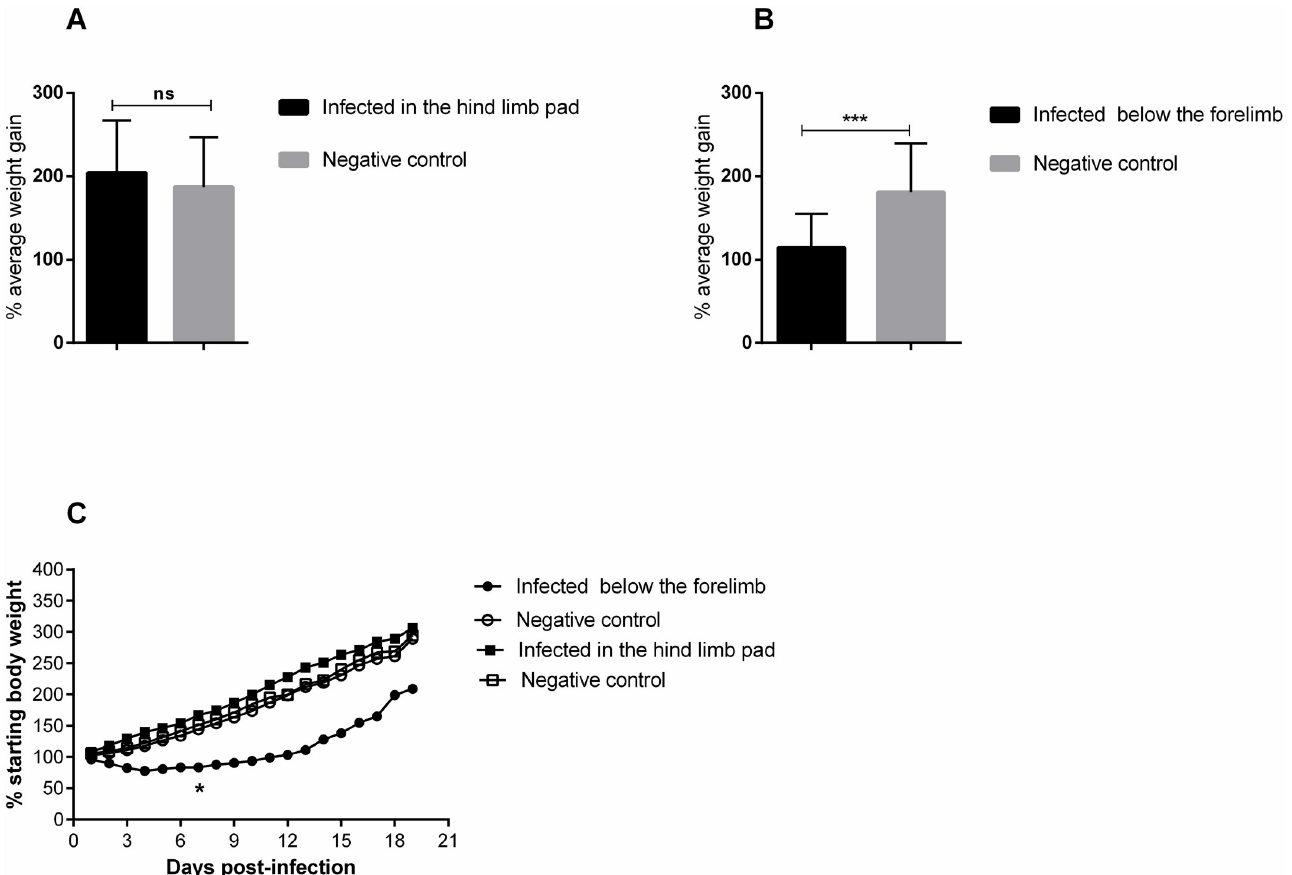
Fig 2. Mayaro virus induces weight loss in 15-day old Balb/c mice. Mice weight was evaluated throughout the experiment. 15-day old Balb/c mice were infected with 2.57 x 10 6 PFU in the rear footpad and 1.25 x 10 7 PFU below the forelimb by subcutaneous injection. A) Infected mice did not present a statistical difference in hind limb pad pathway. B) A statistical difference was observed for the below the forelimb pathway. C) Behavior of the groups throughout the experiment. Control groups received only PBS 1X. The animals were monitored at 24-hour intervals for weight gain or loss, and statistics were ascertained with